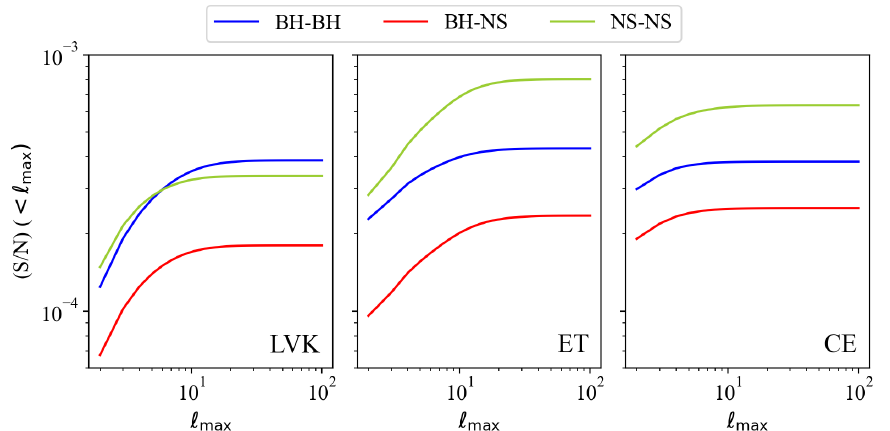
Figure 4. Cumulative S/N for Ω × κ cross-correlation angular power spectrum as a function of (cid:96) max . The curves are evaluated by means of Equations (12) and (13) starting from (cid:96) min = 1. The colour code is the same as in Figure 1.